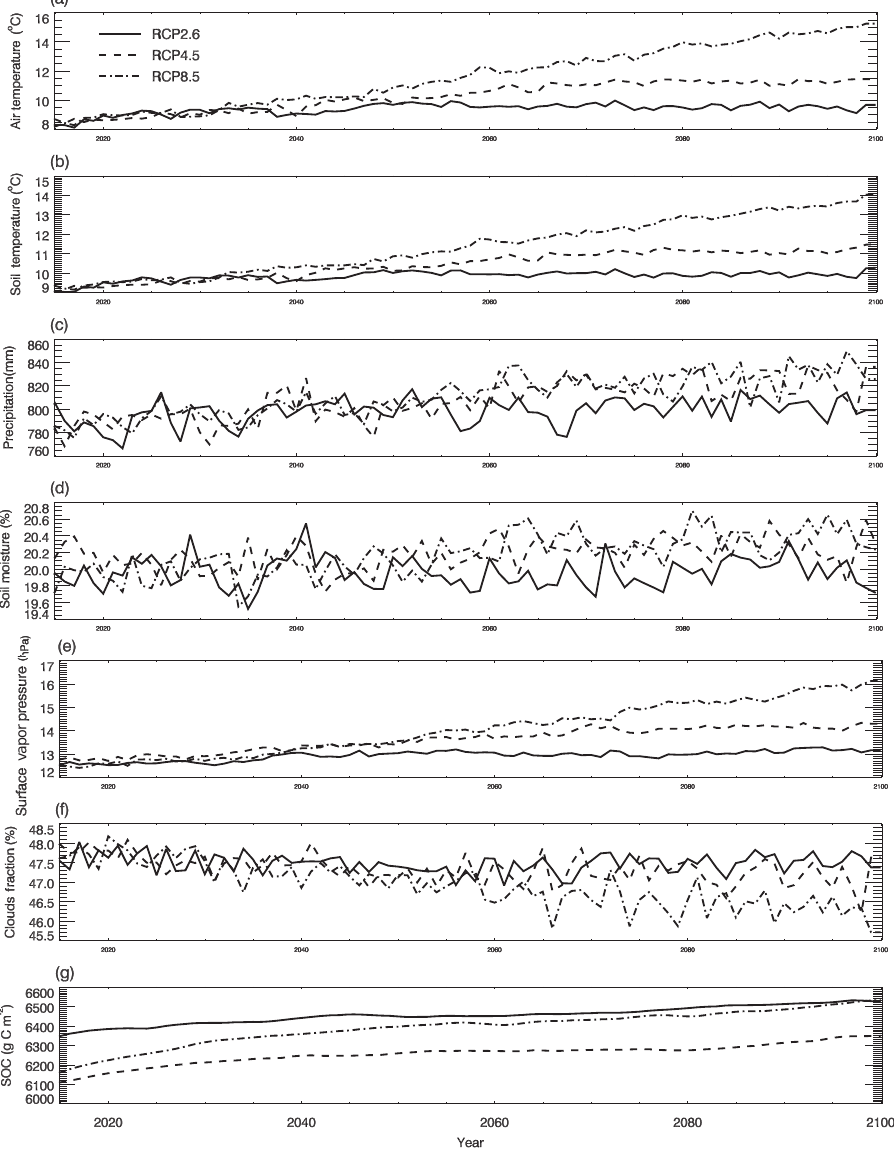
Figure 6. Global land surface (excluding the Antarctic area and ocean area) mean climate from the RCP2.6, RCP4.5 and RCP8.5 data sets and simulated mean soil temperature, moisture and SOC: (a–g) are land surface air temperature ( ◦ C), soil temperature ( ◦ C), precipitation (mm), soil moisture (%), surface water vapor pressure (hpa), cloud fraction (%), and SOC (mgm − 2 ) ,